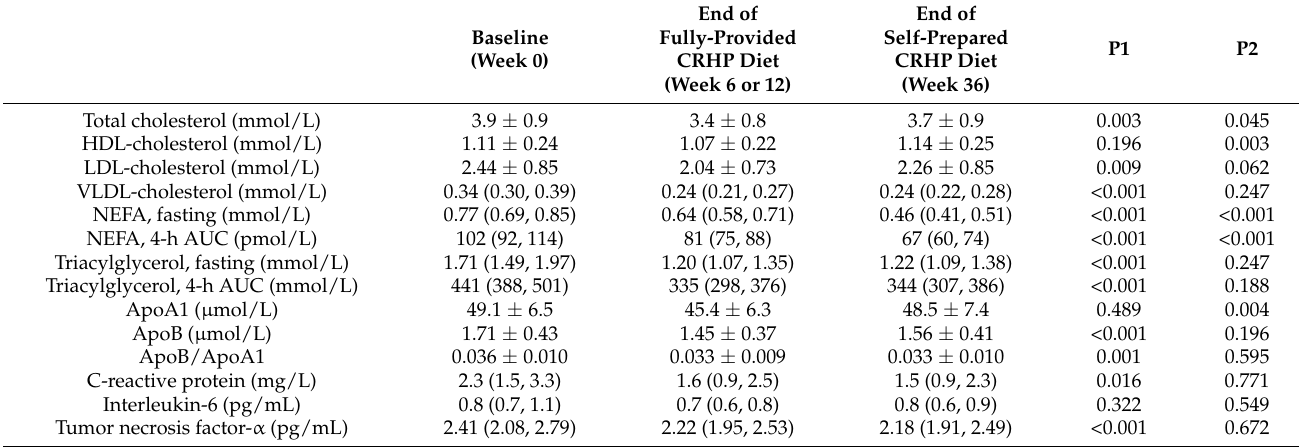
Table 2. Effects of a CRHP diet on lipids, apolipoproteins, and inflammatory markers in patients with